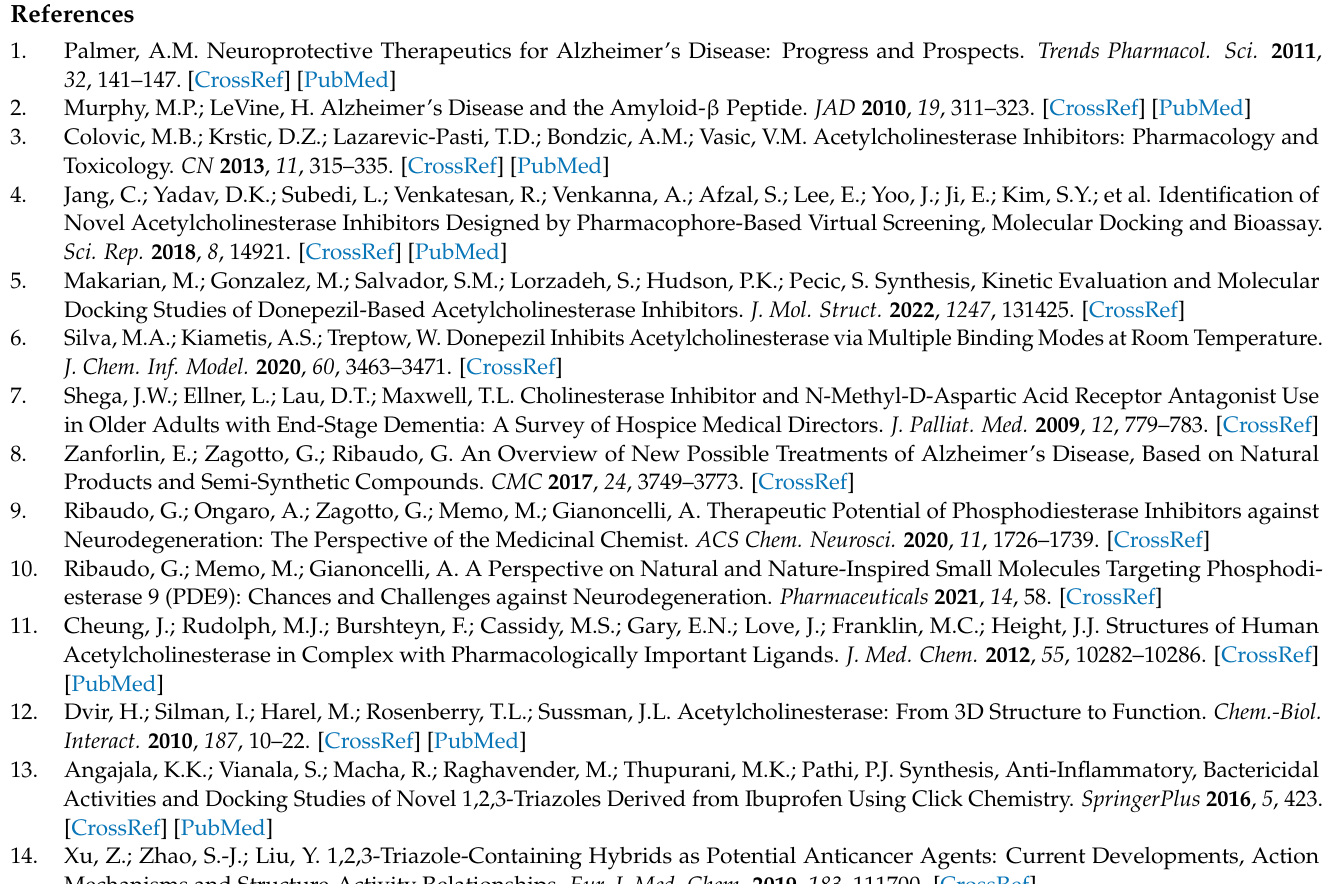
Supplementary Materials: The following are available online, Figure S1: 1-H NMR compound 4 , Figure S2: 13-C NMR compound 4 , Figure S3: 1-H NMR compound 5 , Figure S4: 13-C NMR compound 5 , Figure S5: HSQC compound 5 , Figures S6 and S7: DEPT compound 5, Figure S8a,b: 1H-1H COSY compound 5 , Figure S9: HRMS of 5, Figure S10: IR spectrum, Figure S11: UV spectrum, Figures S12–S14: detailed views of the predicted interaction of ligands with AchE, Figure S15: BOILED-Egg graph, Table S1 1 H and 13 C-nuclear magnetic spectroscopy (NMR) chemical shifts, Tables S2 and S3: overview of the residues interaction with ligands according to molecular modeling studies, Table S4: physicochemical properties of compound 5 calculated by